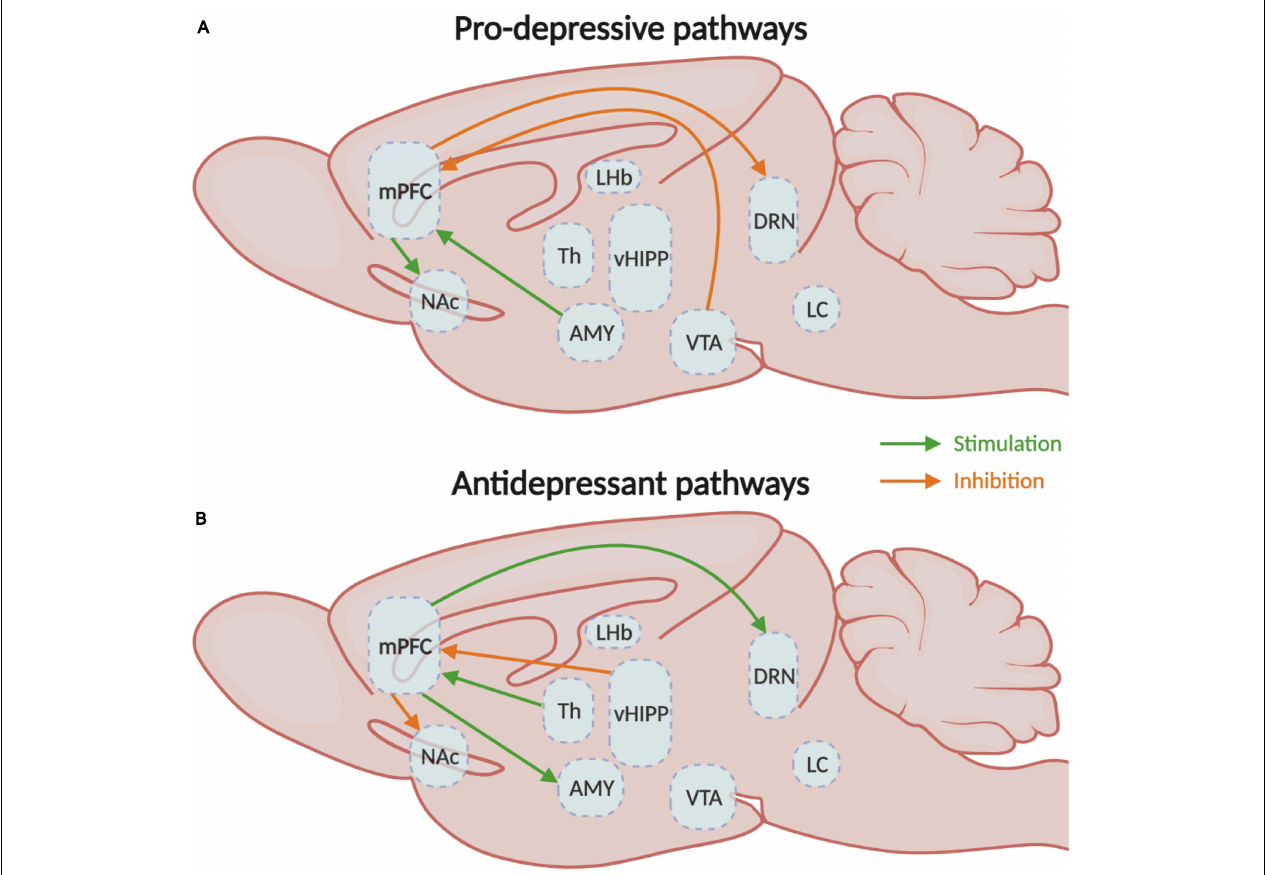
FIGURE 4 | Medial prefrontal circuitry involved in depressive-like behaviors. (A) Schematic representation of the mPFC circuits involved in the expression of either (A) depressive- or (B) antidepressant-like behavioral responses. mPFC, medial prefrontal cortex; NAc, nucleus accumbens; Th, thalamus; vHIPP, ventral hippocampus; VTA, ventral tegmental area. CSDS, chronic social defeat stress; EPM, elevated plus-maze test; FST, forced swim test; NSF, novelty-suppressed feeding test; OFT, open field test; sCVS, subthreshold chronic variable stress; SDS, social defeat stress; SPT, sucrose preference